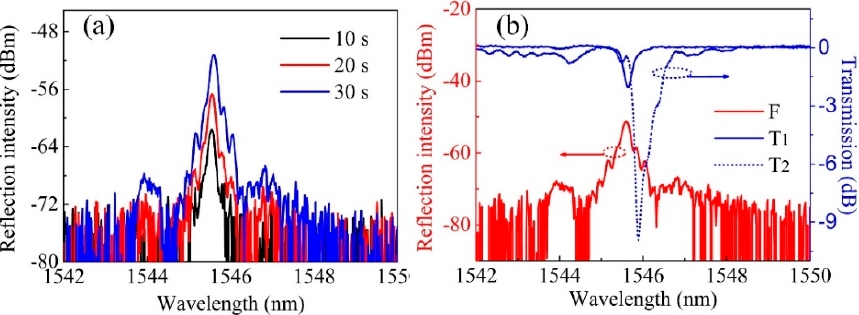
Figure 5. ( a ) Reflection and ( b ) transmission spectra evolutions of the FBG inscribed in a H 2 -loaded SMF.